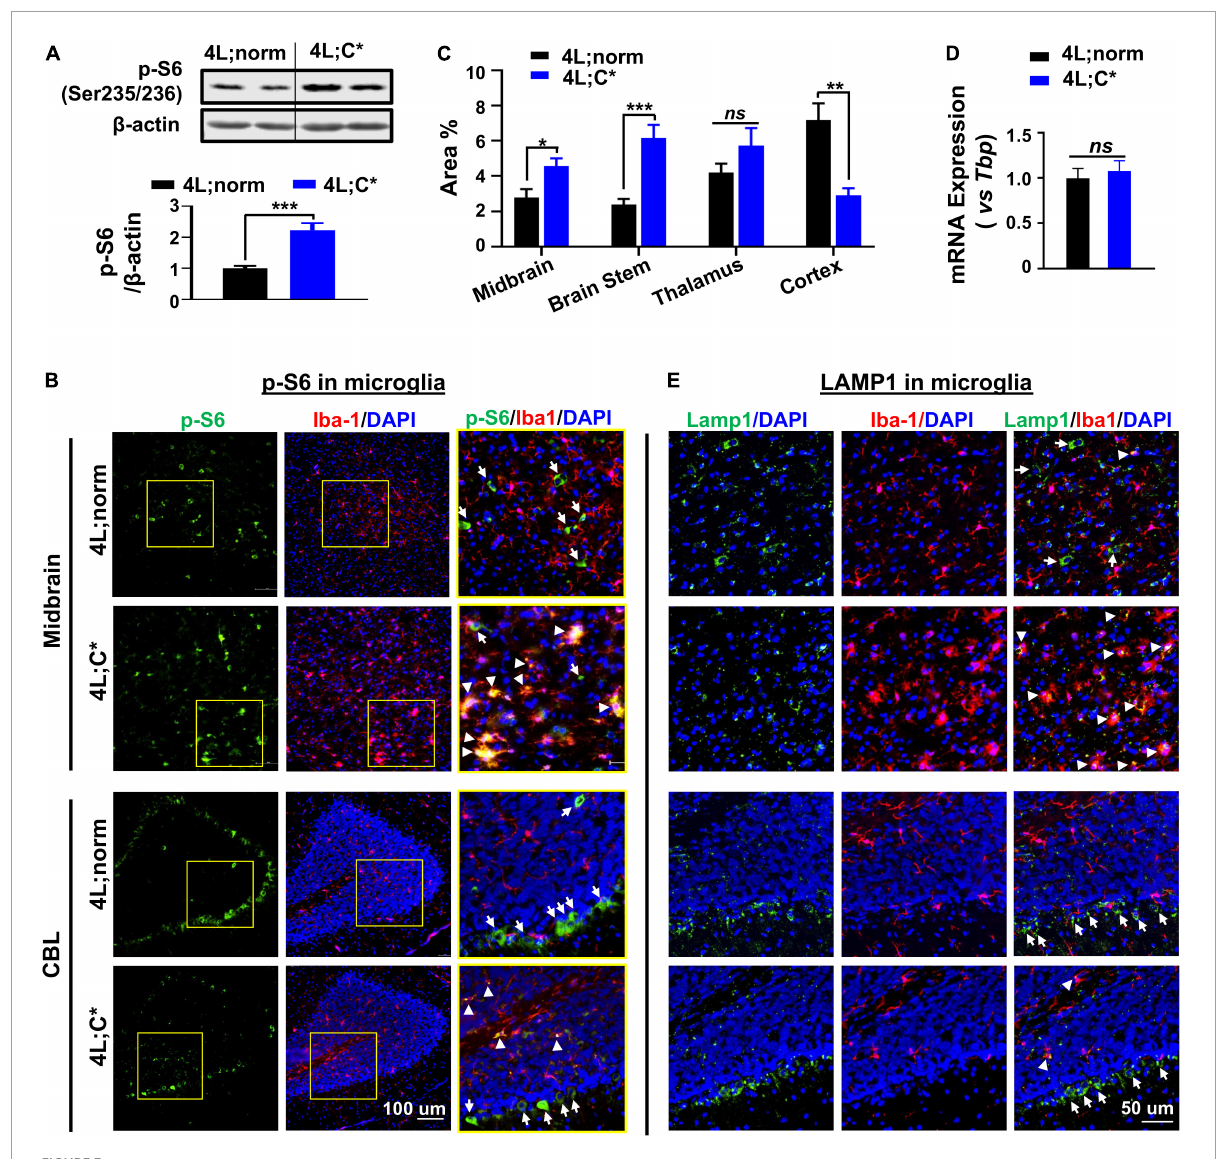
FIGURE3 Diverse expression of p-S6 and Lamp1 in microglia and brain tissues. (A) Protein levels of p-S6 (direct downstream target of mTORC1) were abnormally elevated in 4L;C* brain. Representative immunoblots of brain stem tissues for p-S6 (Ser235/236) are shown (top panel) with semi-quantitation of signal intensity by Image J (bottom panel). Data are presented as mean ± SEM, n = 6–9 per group. *** p ≤ 0.001 by Student’s t -test. (B) Representative views of p-S6 signals in midbrain and CBL regions. Areas highlighted in yellow squares were enlarged and shown in right panel. Strong p-S6 signals are indicated for co-localization with (white triangles) or without (white arrows) Iba1 signals. (C) Semi-quantitative analysis of overall p-S6 signals in different cerebral regions of 4L;C* and controls. Data are presented as mean ± SEM, with 4–7 images analyzed for each region of each animal with two mice per group. * p ≤ 0.05, ** p ≤ 0.01, and *** p ≤ 0.001, ns, non-significant by Student’s t -test. NIS-Elements AR software was used for image analysis. (D) Relative mRNA expression of Lamp1 in brain. Data are presented as mean ± SEM, n = 4. ns, non-significant by Student’s t -test. (E) Representative views of Lamp1 signals. Strong Lamp1 signals are indicated for co-localization with (white triangles) or without (white arrows) Iba1